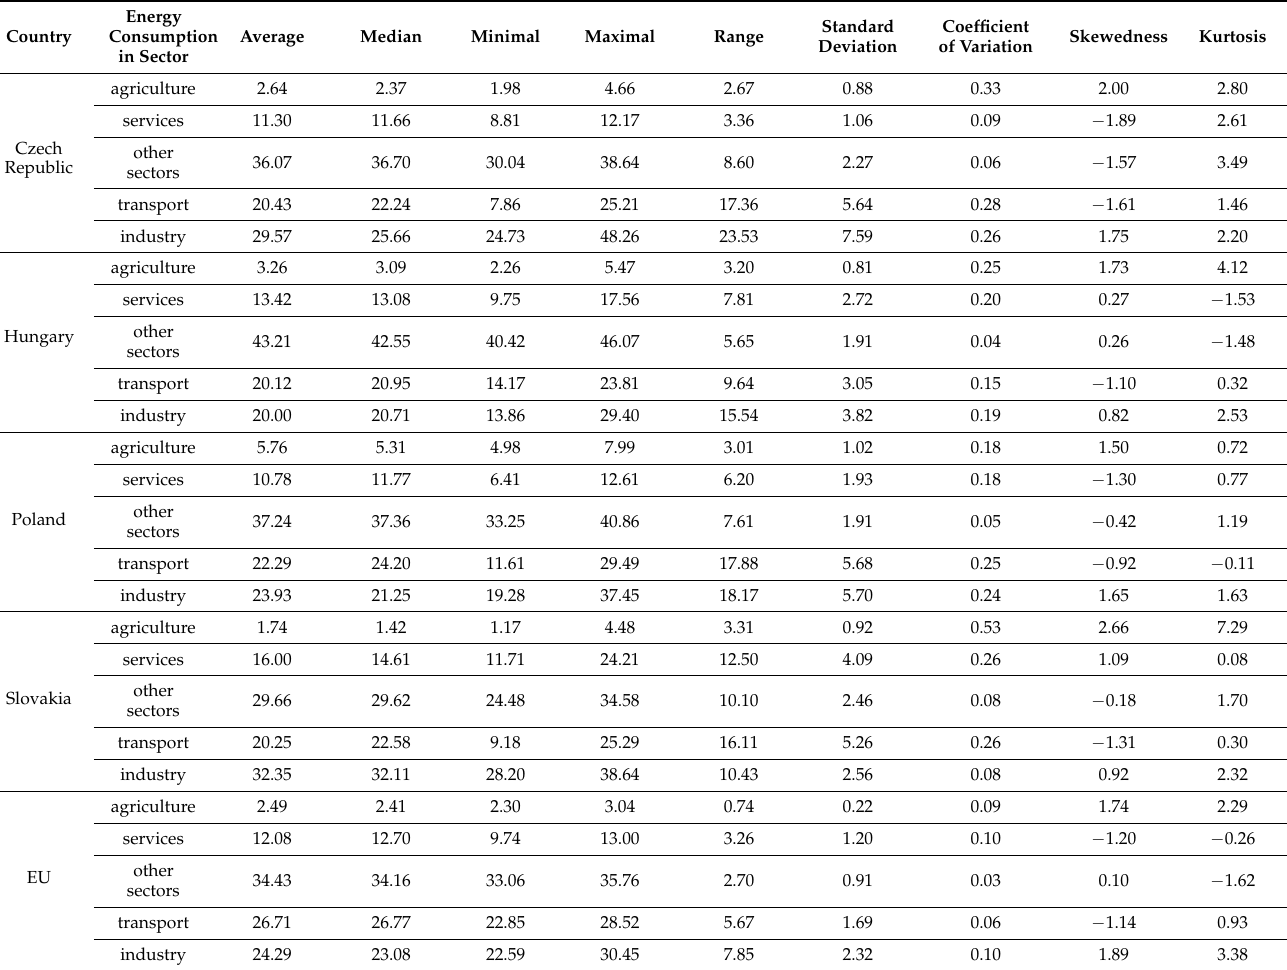
Table 3. Selected characteristics of adopted diagnostic variables for Visegrad Group